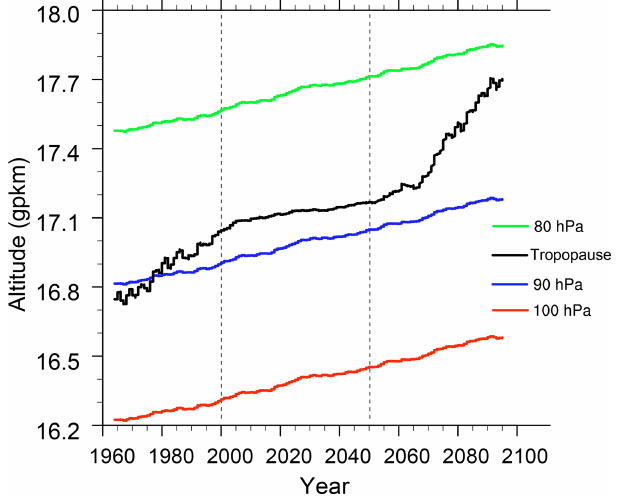
Figure 4. Time evolution of CMAM zonal mean geopotential height (gpkm) of selected pressure levels and of a first lapse rate tropopause averaged between 30 ◦ S and 30 ◦ N smoothed by a decadal running average.